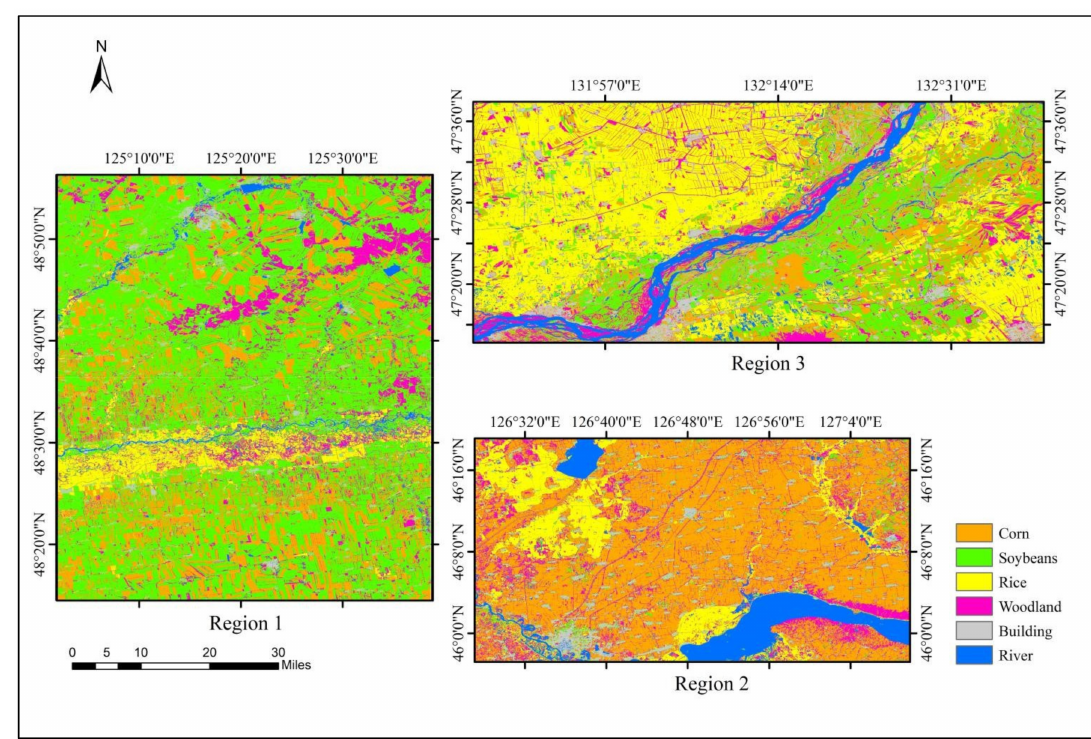
Figure 6. RF classification results in the three study